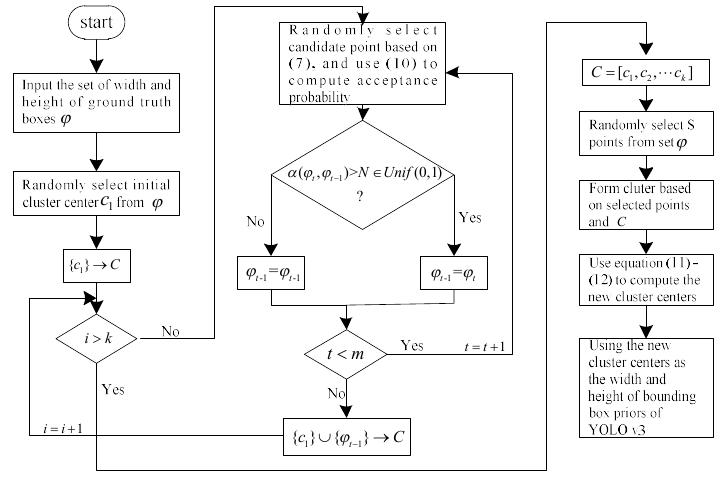
Figure 1. Flowchart of our proposed method.